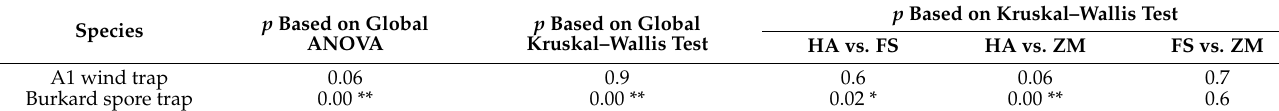
Table 2. ANOVA and the Kruskal–Wallis test for pollen capture differences in the A1 volumetric air sampler and the Burkard Multi-Vial Cyclone Sampler. HA: Helianthus annuus ; FS: Fagus sylvatica ; ZM: Zea mays ; p : significant difference in pollen capture species wise; significance p < 0.05; *: significant and **: highly significant.